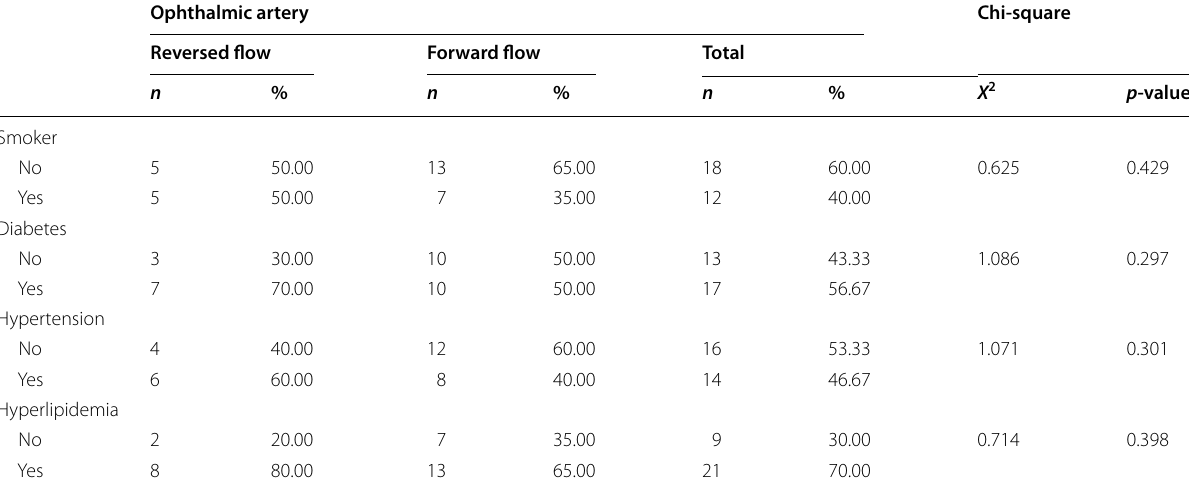
Table 4 Distribution of different risk factors among the two study